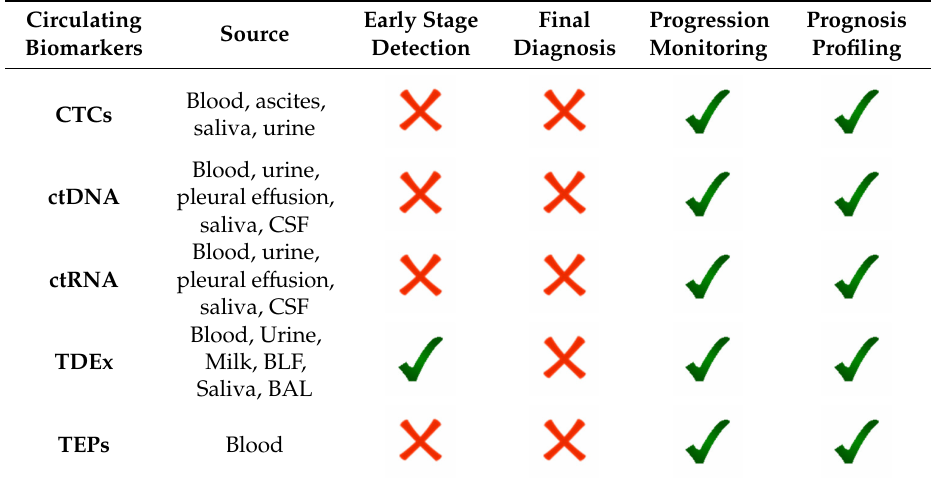
Table 1. Source and clinical use of circulome components